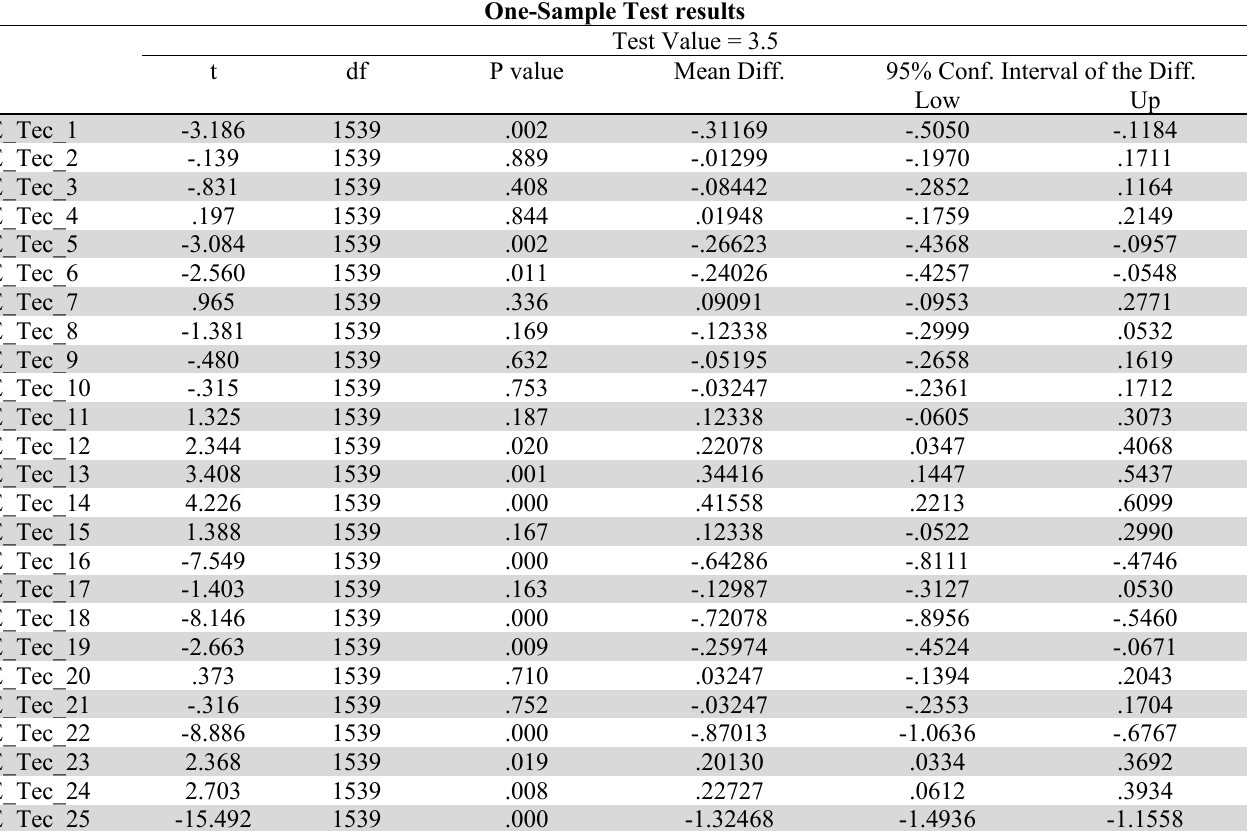
One-Sample Statistics